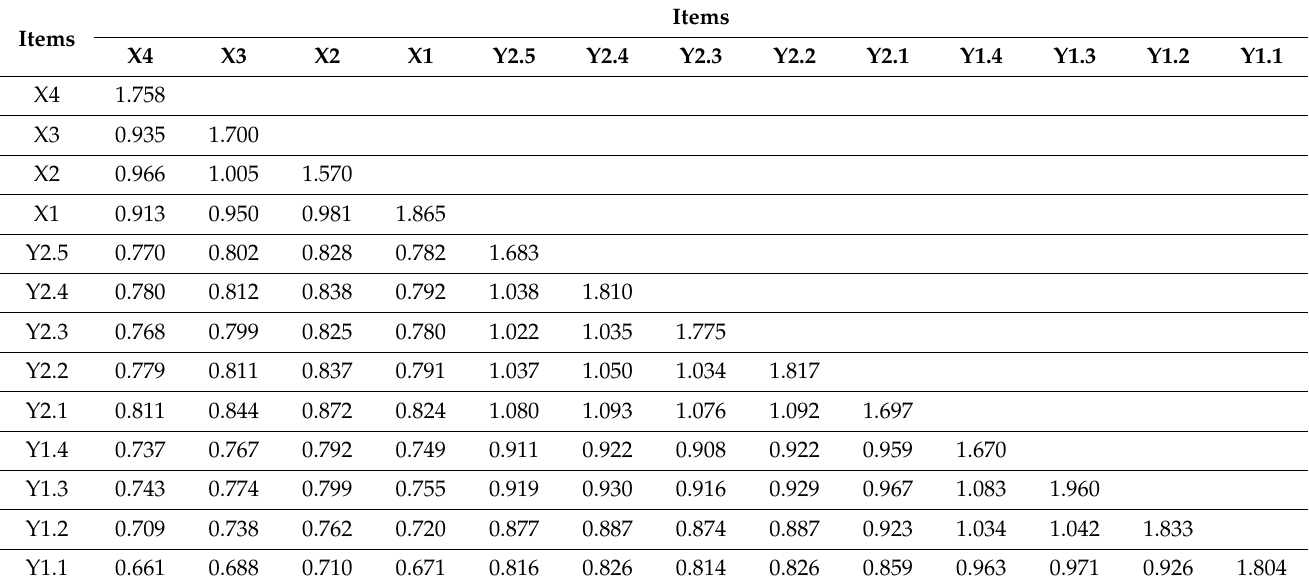
Table 2. Sample covariance matrix.